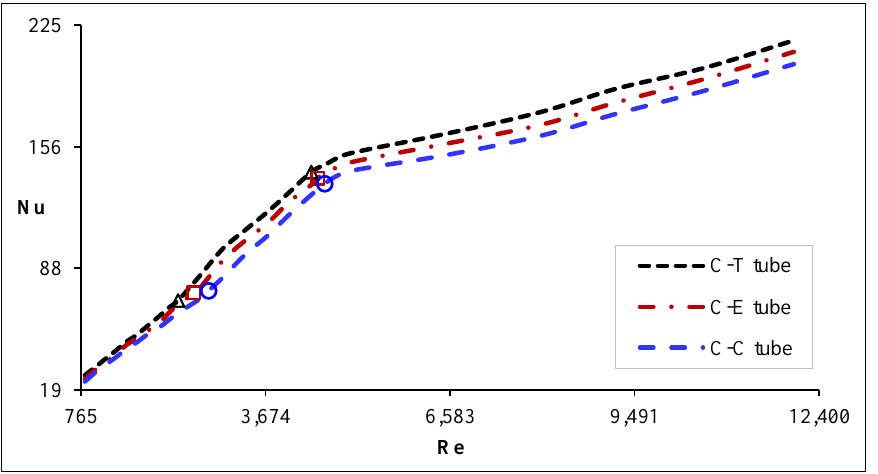
Figure 7. Nusselt number for the flows in the